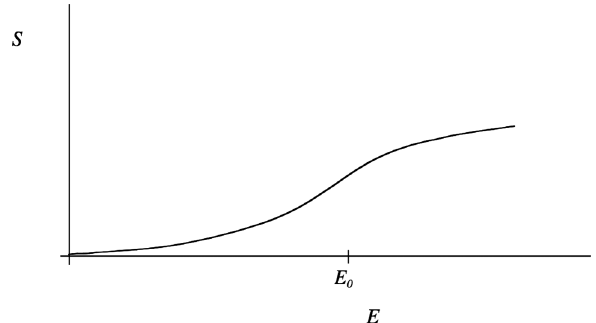
FIG. 2. Graph used in the pretutorial homework assignment. Students were asked to give a graphical interpretation of each of the terms in their Taylor series expansion of entropy as a function of energy about E ¼ E 0 [see Eq.